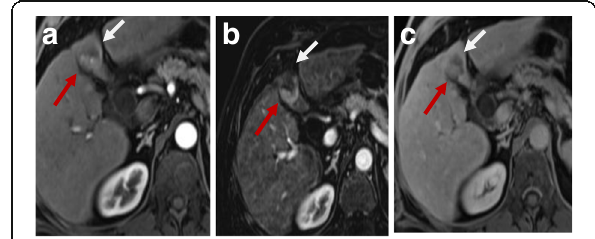
Fig. 6 Hepatic focal lesion after RFA. a Enhanced T1-WI in the arterial phase shows early arterial peripheral nodular enhancement (red arrow). b Subtracted T1-WI arterial phase shows true enhancement of the nodule (red arrow). c Enhanced T1-WI in the delayed phase shows washout with capsule enhancement (red arrow). Overall post-treatment assessment is LR-TR